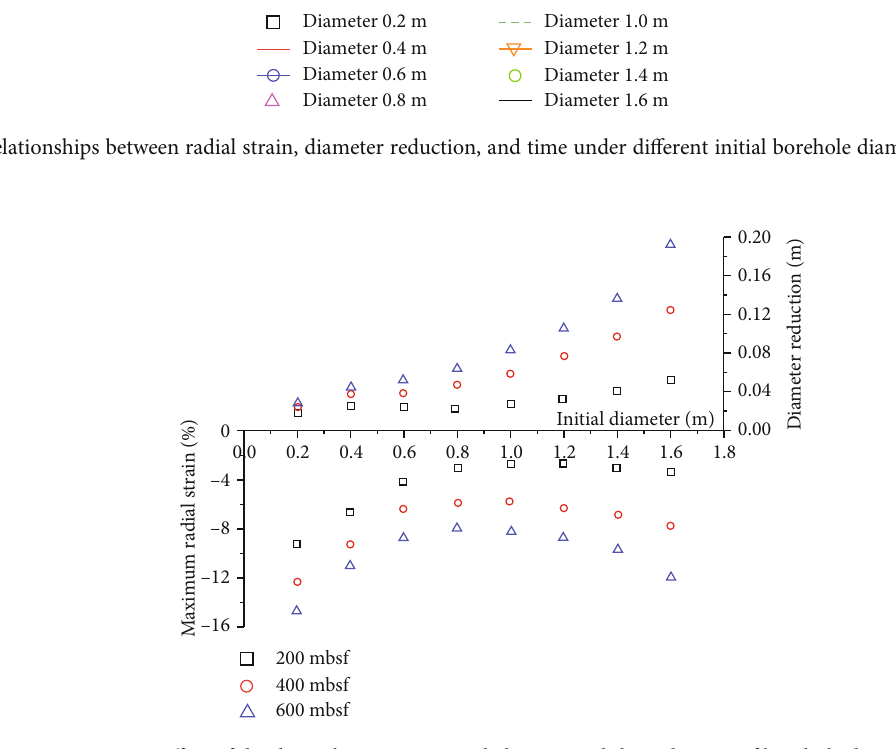
Figure 15: E ff ect of depth on the maximum radial strain and the reduction of borehole